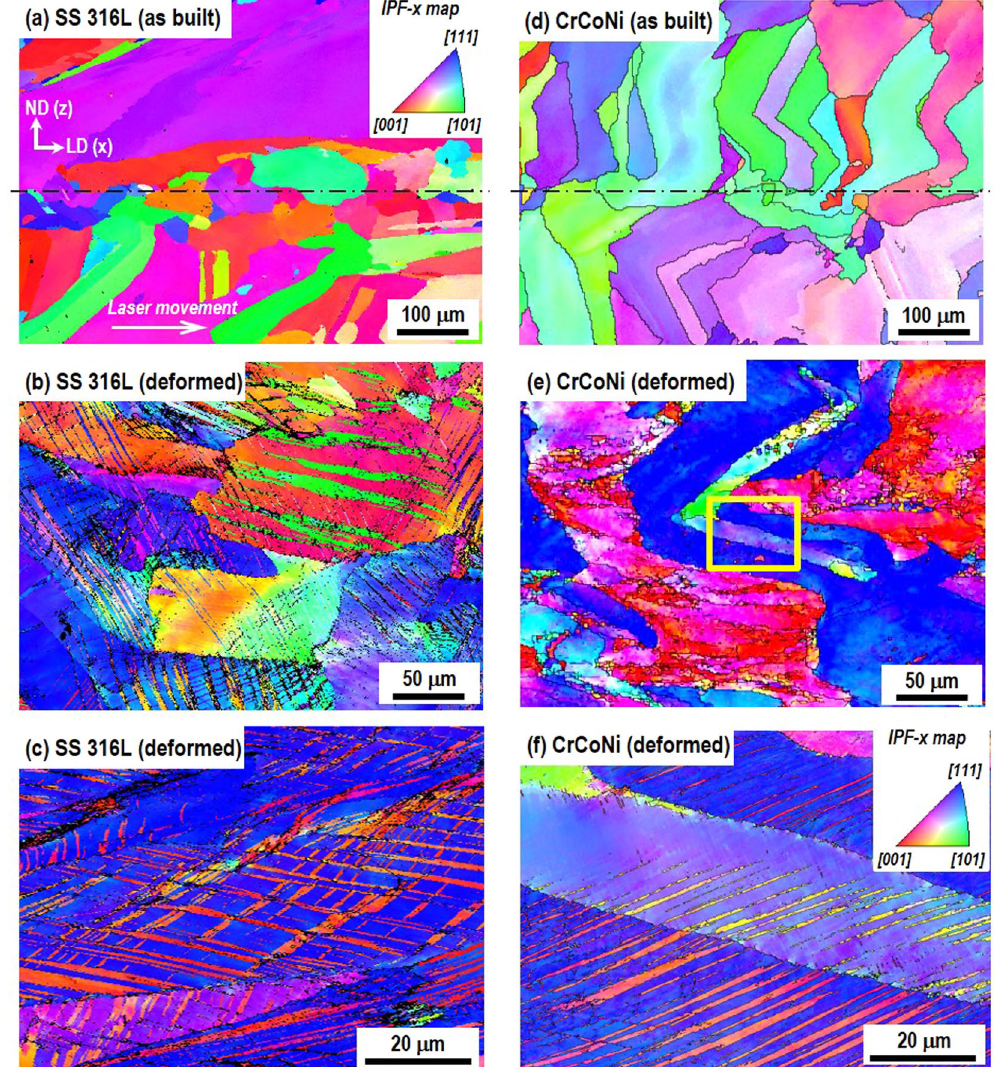
Figure 2. Inverse pole figure (IPF) maps performed at LD-ND plane of the specimen by EBSD and the orientations were analyzed along LD (x) axis (//loading direction, IPF-x map); ( a ) as built and ( b , c ) deformed AM SS 316 L, ( d ) as built and ( e , f ) deformed AM CrCoNi